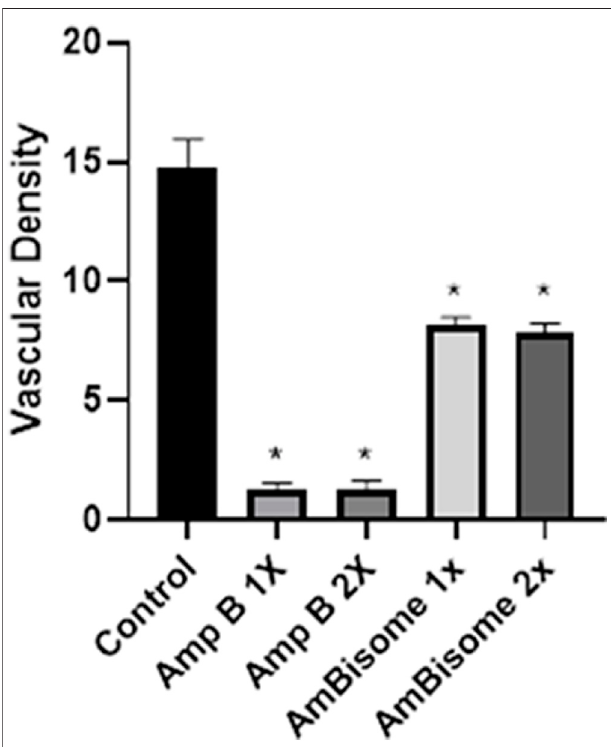
FIGURE 6 | Vascular density following Amphotericin B and AmBisome. Control group, Amp B 1x and 2x, and L-Amp1 X and 2X, respectively. A signi fi cant reduction in vascular density is seen in both groups that received Amp B and AmBisome. The embryos that received the Amp B exhibited less vascular density than AmBisome (error bars show mean standard error; * p < 0.05 compared control group).